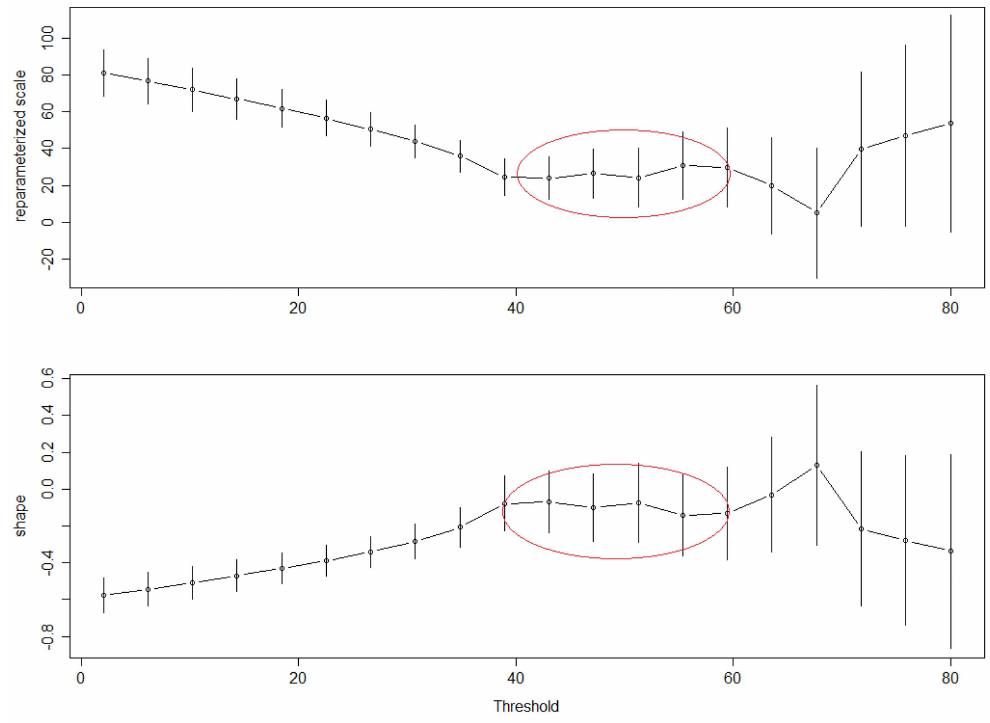
Figure A6. Parameter estimates against threshold for daily rainfall data at Kokoro station (second